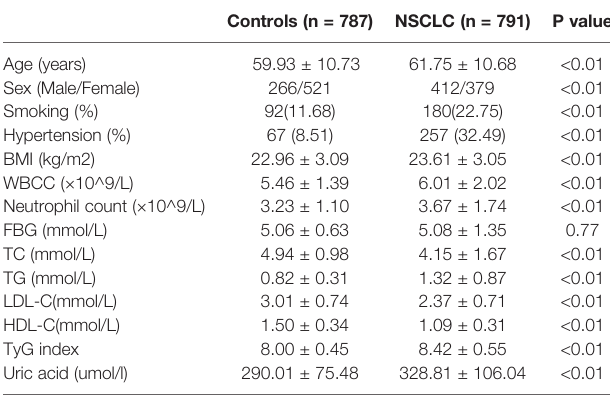
TABLE 1 | Demographic and clinical characteristics of all